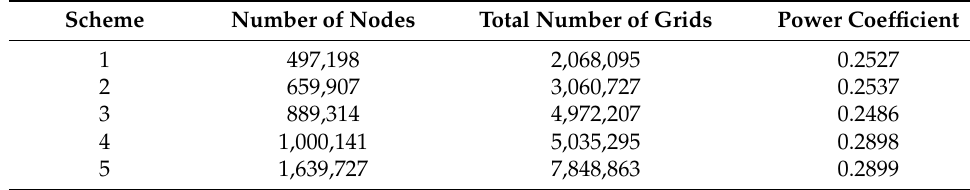
Table 4. Grid independence